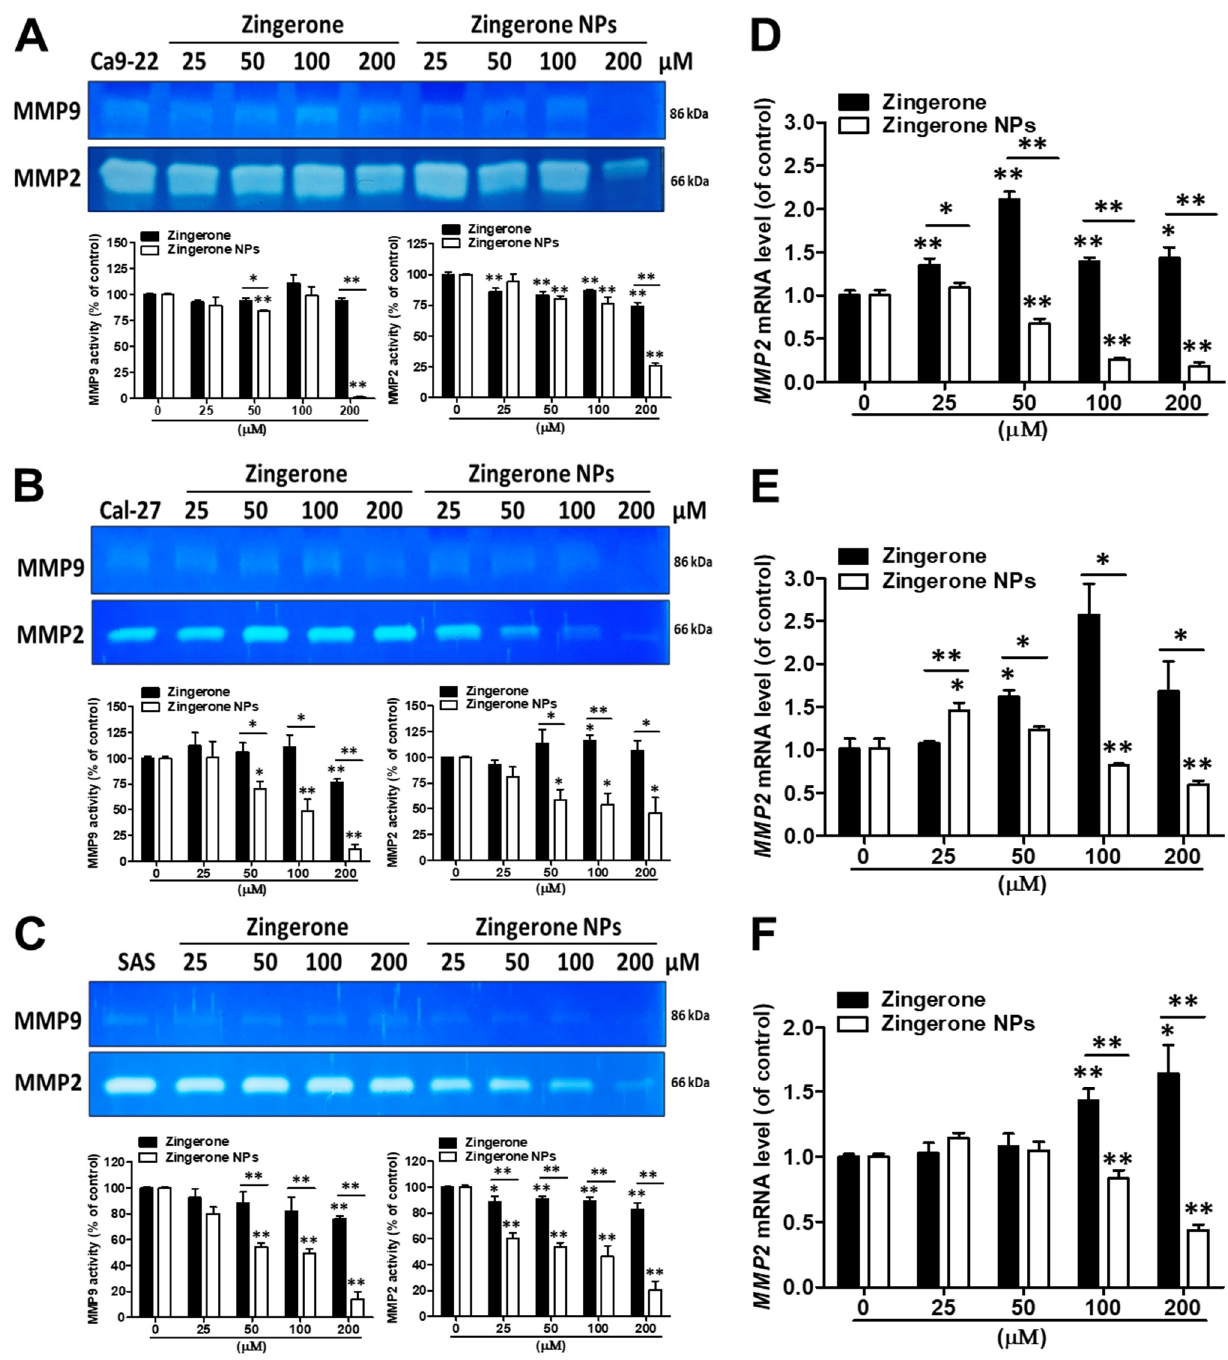
Figure 6. Effects of zingerone NPs on MMPs activity of human OSCC cell lines. Cells were incubated in serum-free DMEM and contained with various doses of zingerone and/or zingerone NPs for 24 h. The conditioned media of ( A ) Ca9-22 cells, ( B ) Ca1-27 cells, and ( C ) SAS cells were collected to analyze MMP activity, including MMP2 and MMP9, using a gelatin zymography assay. Moreover, the mRNA expression levels of MMP2 in ( D ) Ca9-22 cells, ( E ) Ca1-27 cells, and ( F ) SAS cells were analyzed using qPCR analysis. Data are mean ± SEM of three independent experiments. * p < 0.05, ** p < 0.01.